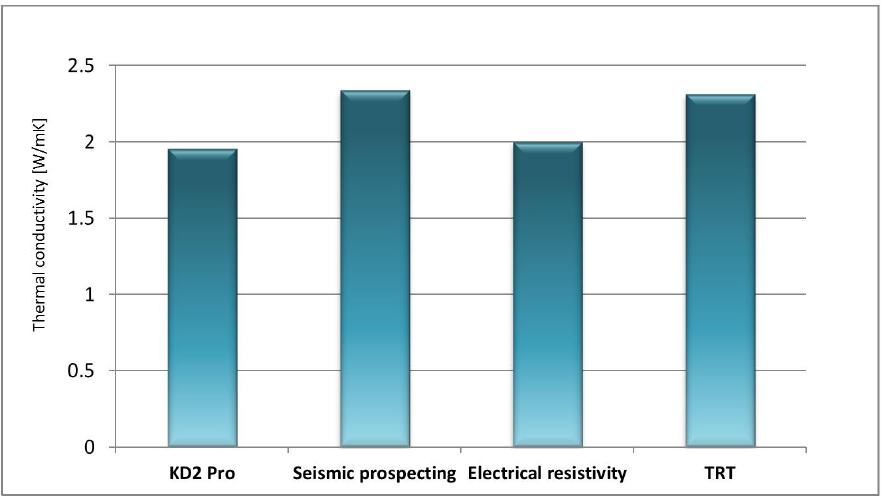
Figure 10. Thermal conductivity results of the implementation of the methodology used in this study.